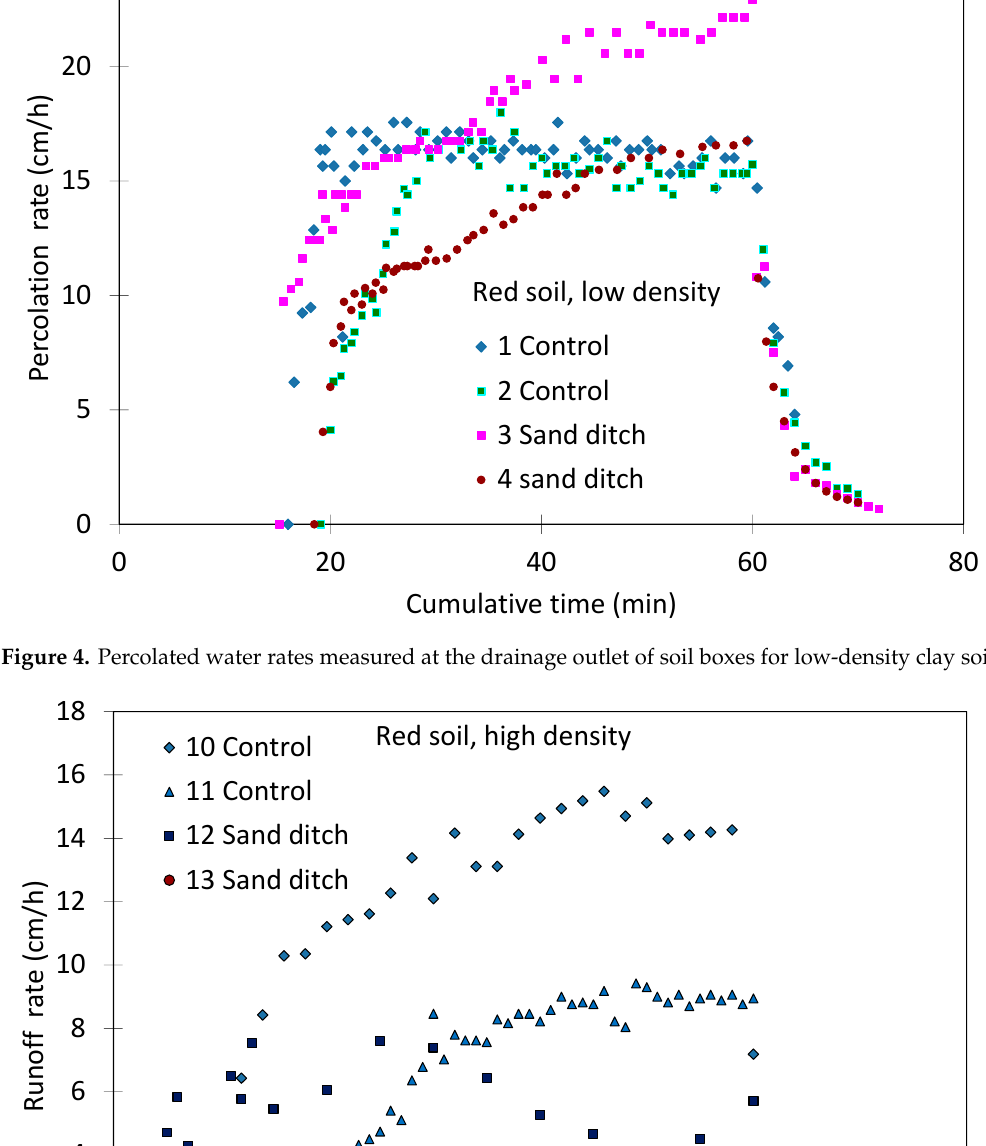
Figure 5. Runoff rates measured at the runoff outlet of soil boxes for compacted high-density clay soil.